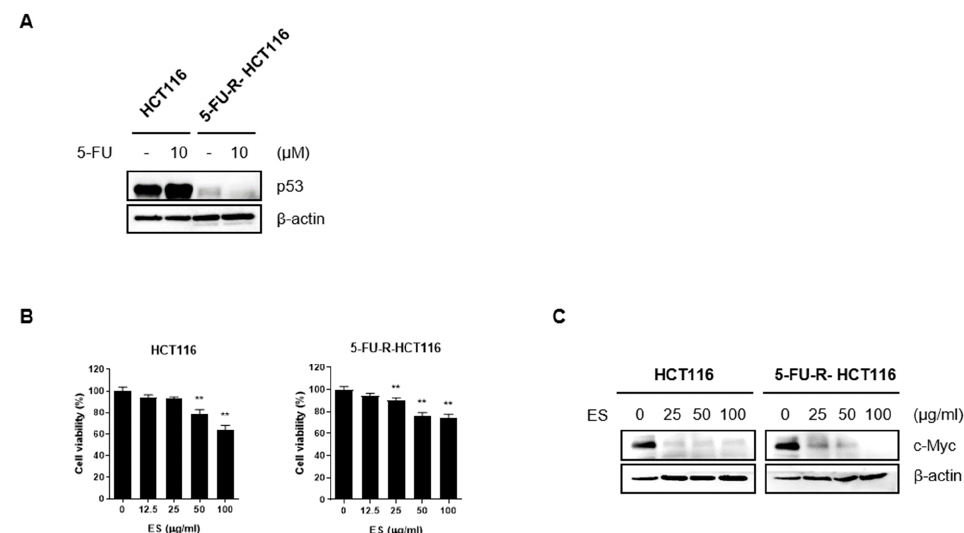
Figure 6. ES inhibits c-Myc expression in normal colon cancer cells and colon cells resistant to 5-FU. ( A ) After making cells resistant to 5-FU, we con fi rmed that the HCT116 cells were resistant to 5-FU by checking the expression level of p53 using Western blo tt ing. In normal HCT116 cells, p53 expres-